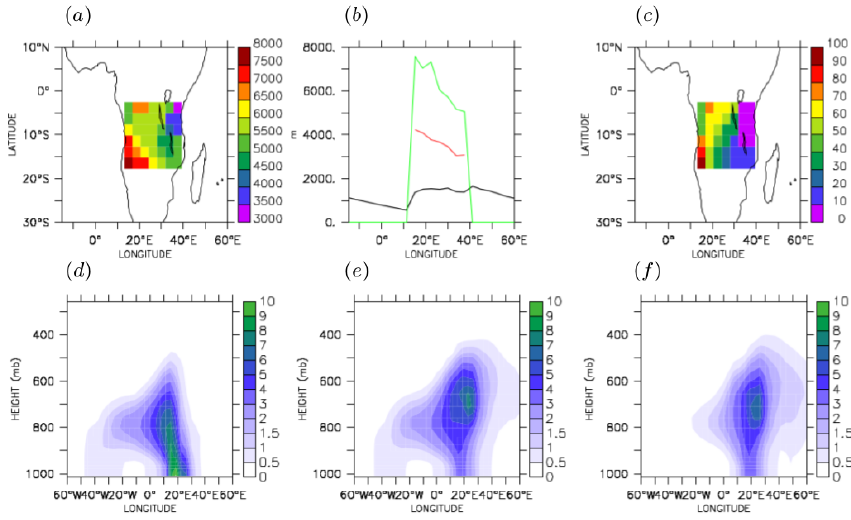
Figure 8. Simulations performed using the pyro-EDMF plume rise model of Rio et al. (2010) for sub-Saharan Africa between 10 and 30 July 2006. In the upper panel, (a) shows the maximal injection height of CO 2 emissions simulated with the LMDZ model and pyro-EDMF between 5 and 20 ◦ S over the 20 days of the simulation. (b) reports the maximal injection height (green), mean injection height of emissions injected above the boundary layer height (red), and mean boundary layer height (black) averaged between 5 and 20 ◦ S altitude and over the 20 days of the simulation. (c) shows the percentage of cases for which the injection height passes the boundary layer height. In the lower panel, (e) shows the averaged vertical distribution of CO 2 mixing ratio (ppmv) for the same reference simulation and (d) for simulations = 0 . 1 (right). The reference simulation without pyro-EDMF and (f) with pyro-EDMF set up with a lower value of the ratio β = entrainment detrainment in (e) uses a value of β = 0 . 4. Figure from Rio et al.